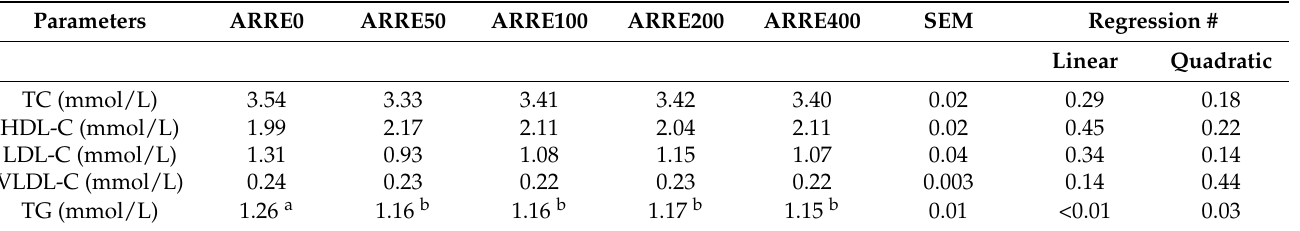
Table 8. The effect of dietary supplementation of ARRE on the serum lipid profile of broiler